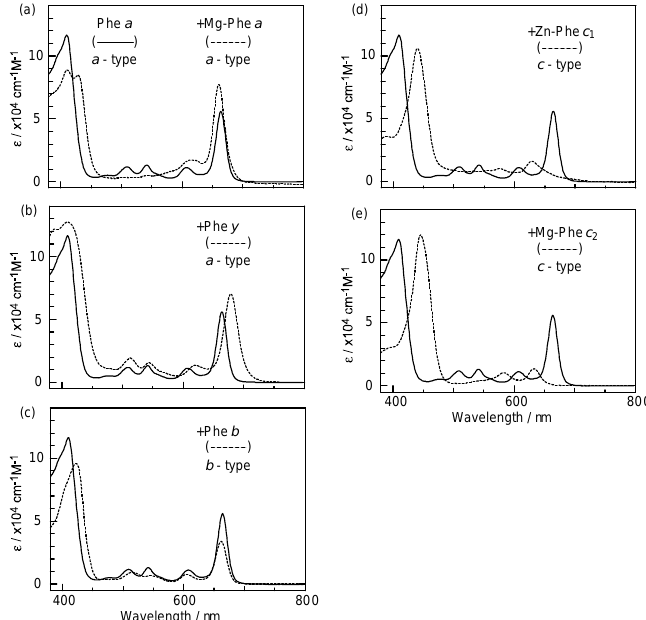
Figure 45. The electronic absorption spectra of the pairs of co-sensitizers in ethanol solution. (a) Phe c + Mg-Phe a , (b) Phe a + Phe y , (c) Phe a + Phe b , (d) Phe a + Zn-Phe c and (e) Phe a + Mg-Phe c 2